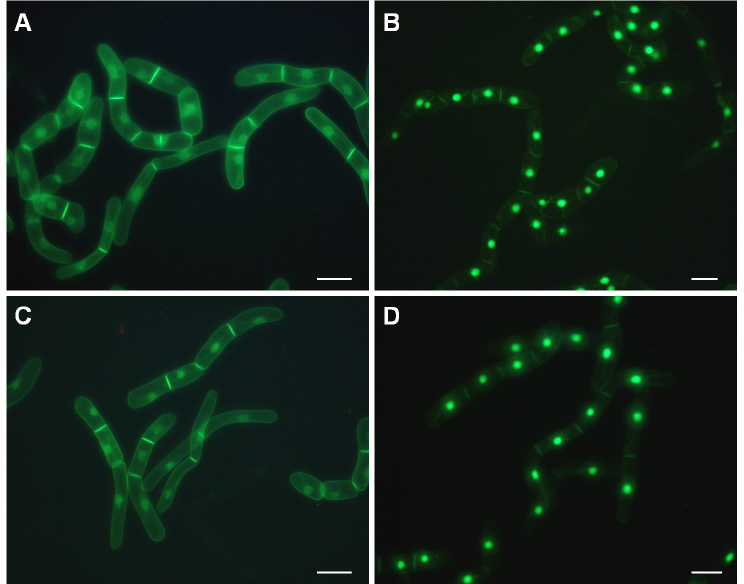
Figure 1. Reproducibility of results on a population of treated BY-2 cells. Low magnification fluorescence images of large numbers of cloned BY-2 cells expressing �� -GFP-DB-CVIL (cf. Gerber et al. , 2009). Images were taken with a Nikon E800 microscope equipped with a 6 DXM11200 CCD color camera (specifications: 20 x 0.45 objective; filters: Ex460–500, DM505, EM510–560). A : Untreated cells; B – D : cells treated with 30 µM oxoclomazone (OC, B ), 5 µM mevinolin (MEV, C ) and 30 µM OC plus 5 µM MEV ( D ). The white bar represents 50